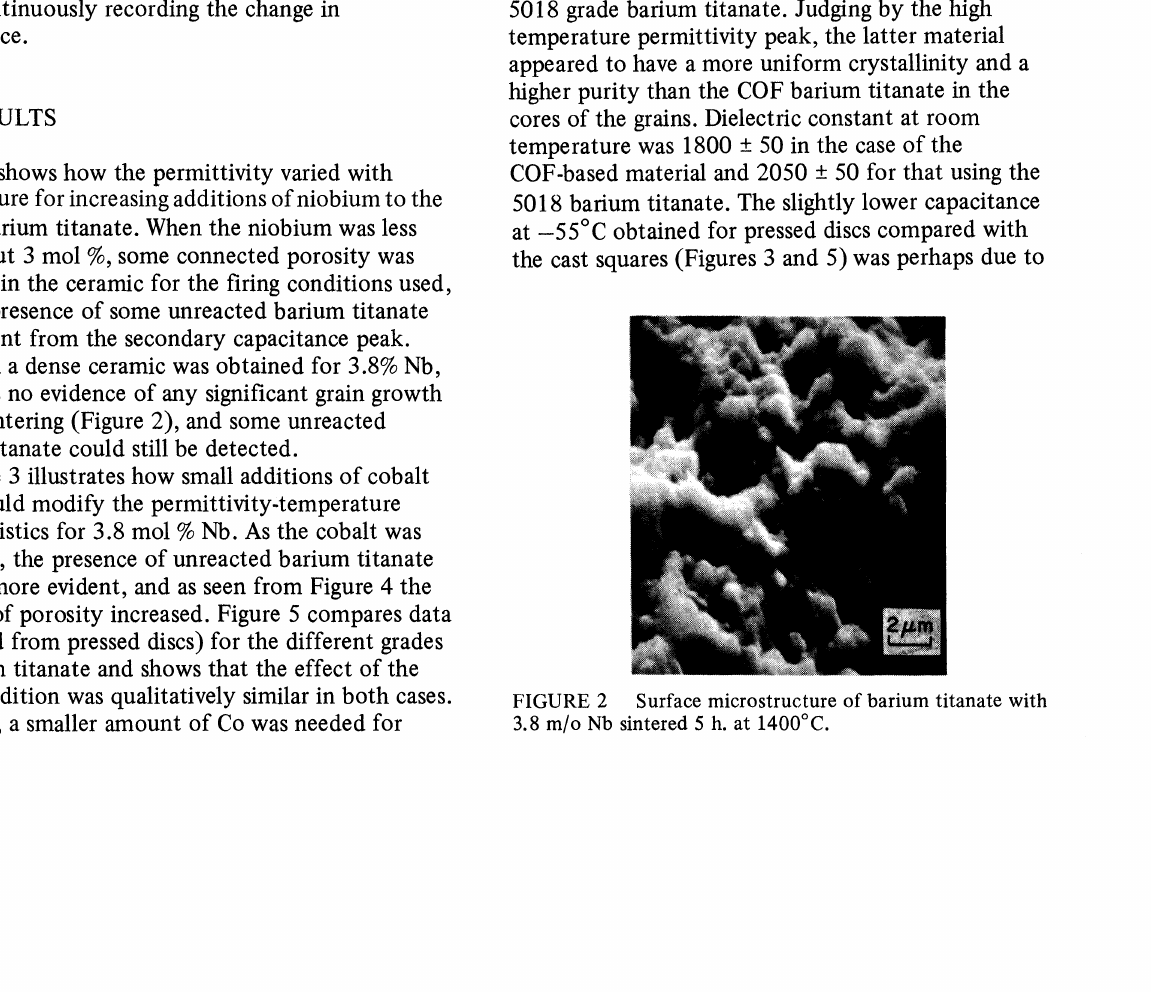
Influence of niobium oxide on the permittivity of barium titanate sintered 5 h. at 1400C.